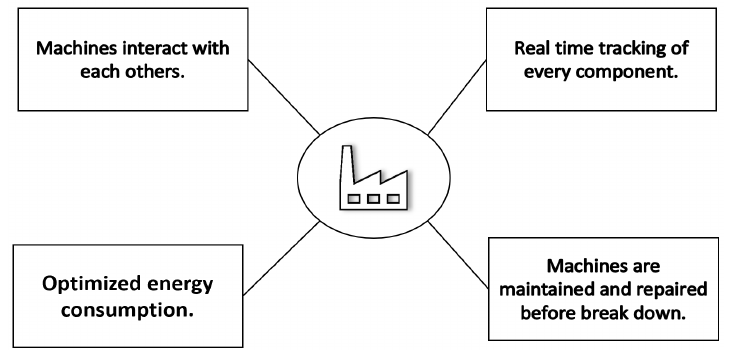
Figure 4. Smart factory features.